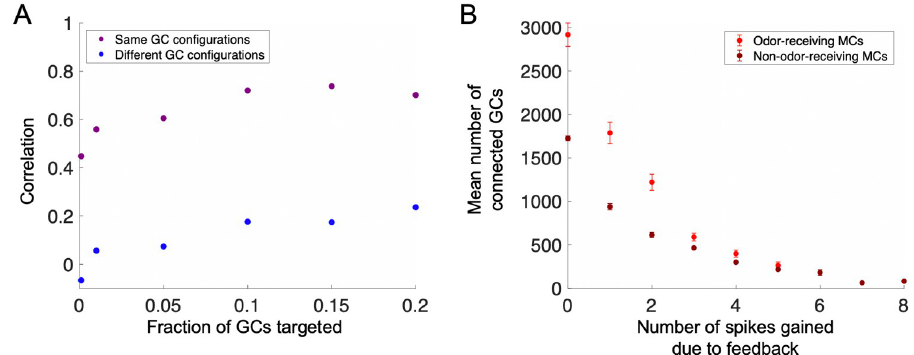
Fig 6. Network architecture and the effects of external feedback to the OB. (A) The effects of randomly distributed, excitatory feedback to GCs depend on the OB network’s inherent connectivity and are relatively invariant to the specific GCs targeted. We presented an odor to the network without and then with external feedback to GCs, and measured the change in MC firing rate. For each feedback level, we ran three trials; the first two took place in the same MC-GC network, but targeted non-overlapping sets of targeted GCs. The third trial took place in a second network with the same MCs but a different spatial configuration of GCs. We computed the Pearson correlation for successive time windows of length 10 ms between the vector of feedback-driven changes in odor-receiving MC firing rates for the first two trials, in the same network (purple), and the first and third trial, in different networks (blue). We found that even for small numbers of targeted GCs, the mean correlation over time was high for the same-network trials despite targeting different sets of GCs, but was lower for the different-network trials. (B) MCs which connect to the fewest GCs are most affected by direct excitatory feedback. We randomly distributed excitatory feedback to 20% of MCs during odor presentation and recorded the resulting change in firing rate. MCs with larger firing rate increases tended to connect to a smaller number of GCs for both odor-receiving (red) and non-odor-receiving (dark red) MCs. Vertical lines indicate standard error. Data compiled from n = 5